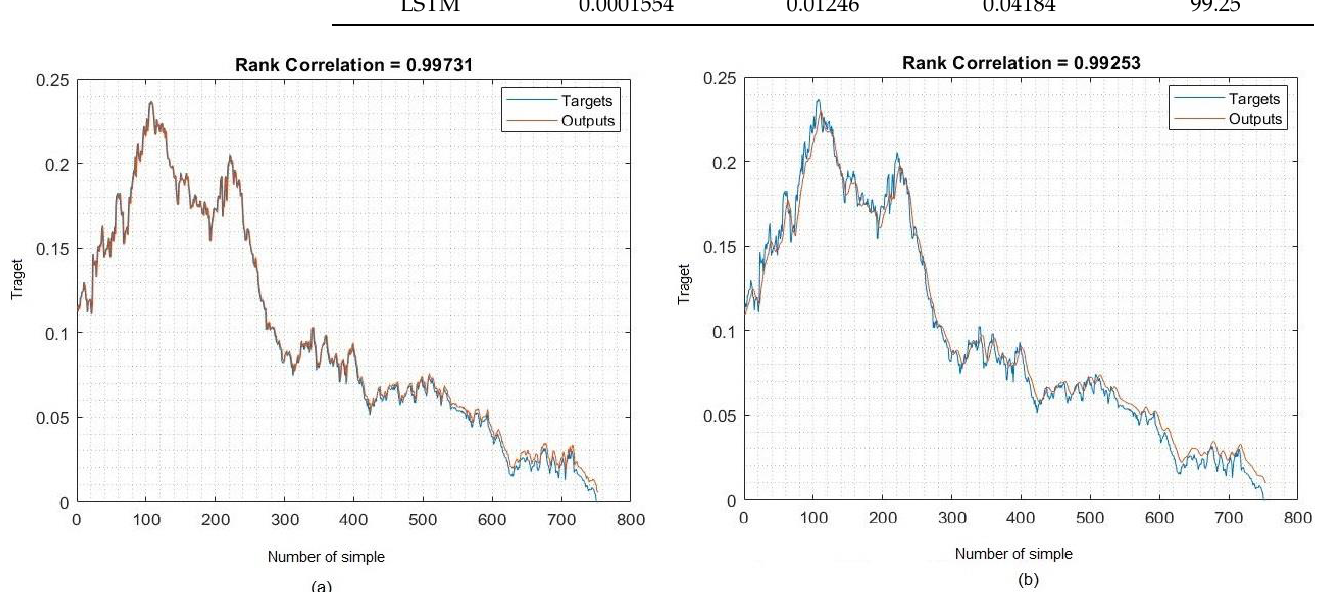
Figure 11. Histogram of the deep learning models ( a ) CNN-LSTM and ( b ) LSTM for predicting the Apple stock market closing price during the training phase.